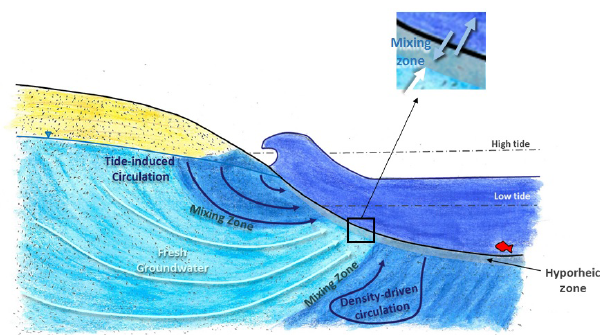
Figure 1. Conceptual representation of the different scales of groundwater–surface-water mixing in the intertidal zone (modified from Heiss and Michael,